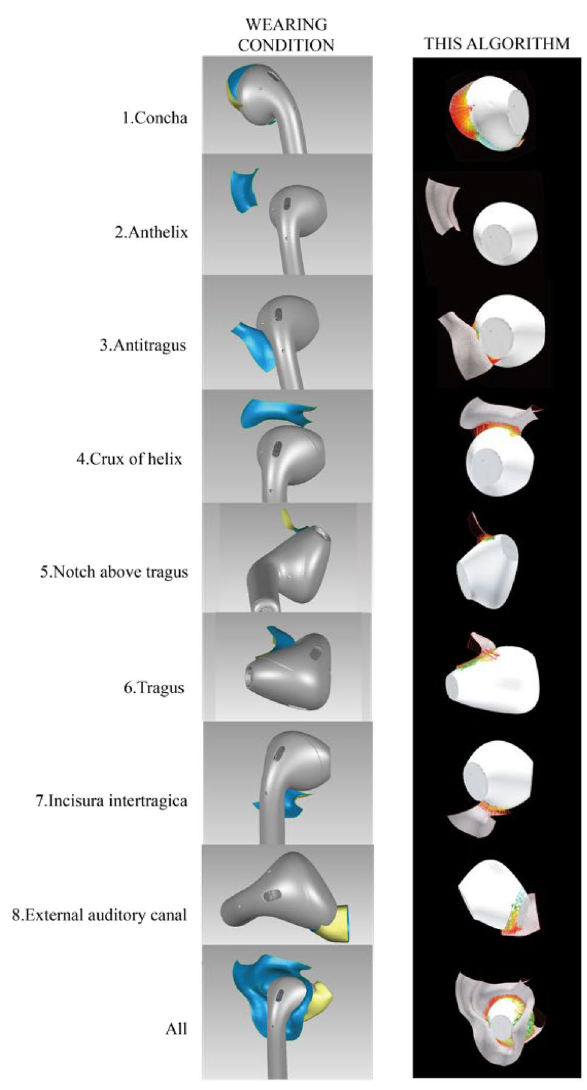
Figure 9. Screenshots of actual wearing condition (left), visual effect of deviation analysis by using deviation analysis algorithm (right).